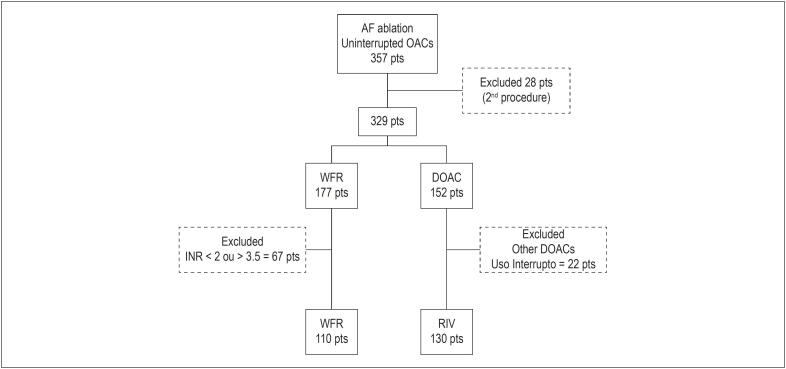
Study flowchart. OAC = oral anticoagulant; WFR: warfarin; DOAC: direct acting oral anticoagulants; RIV: rivaroxaban; INR: International Normalized Ratio.